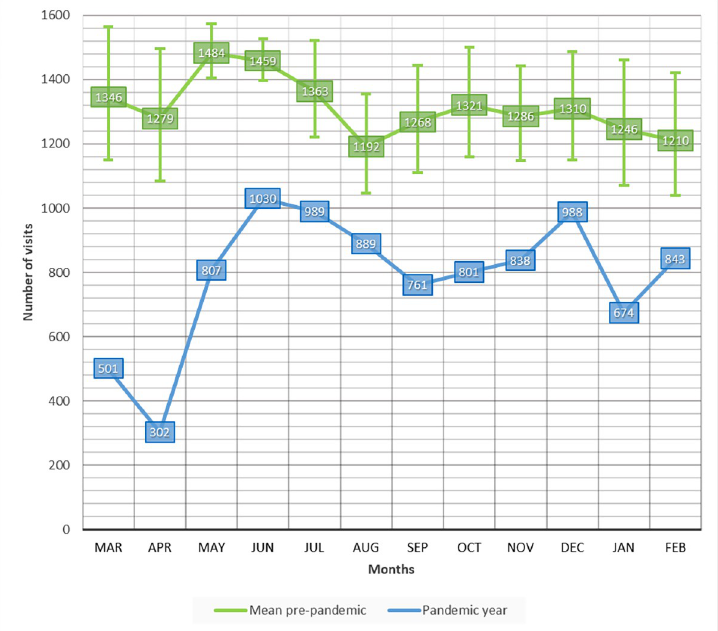
Fig 1. The number per visits per month in the ophthalmological emergency department. The mean number of visits per month from January 2015 to February 2020 is shown in green. The number of visits per month from March 2020 to February 2021 is shown in blue. Error bars represented the maximum and minimum number of visits each month from January 2015 to February 2020.